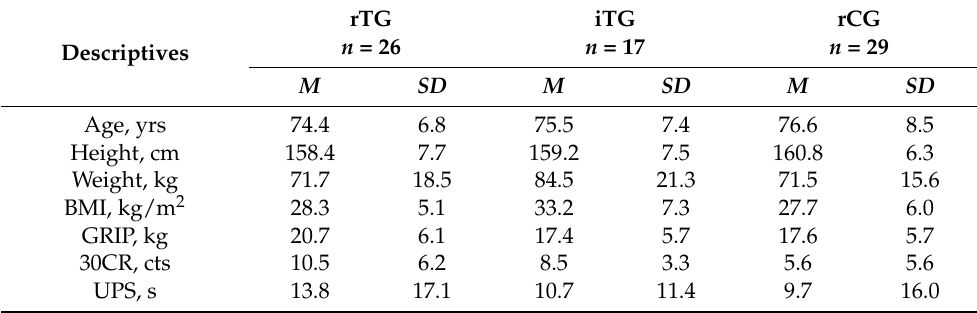
Table 2. Baseline Characteristics of